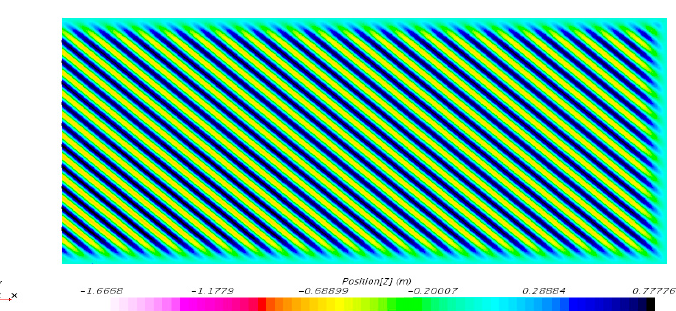
Figure 4. Grids’ refinement around the oil spout.